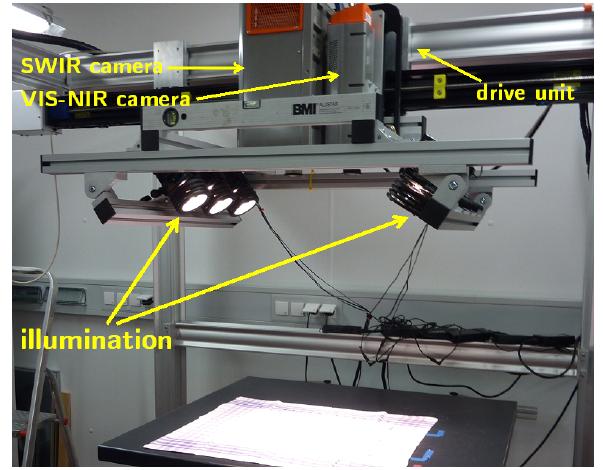
Figure 2: Setting for the image acquisition. Two cameras are located at center top edge of the image facing downwards. The visible near infrared camera did not take part in the